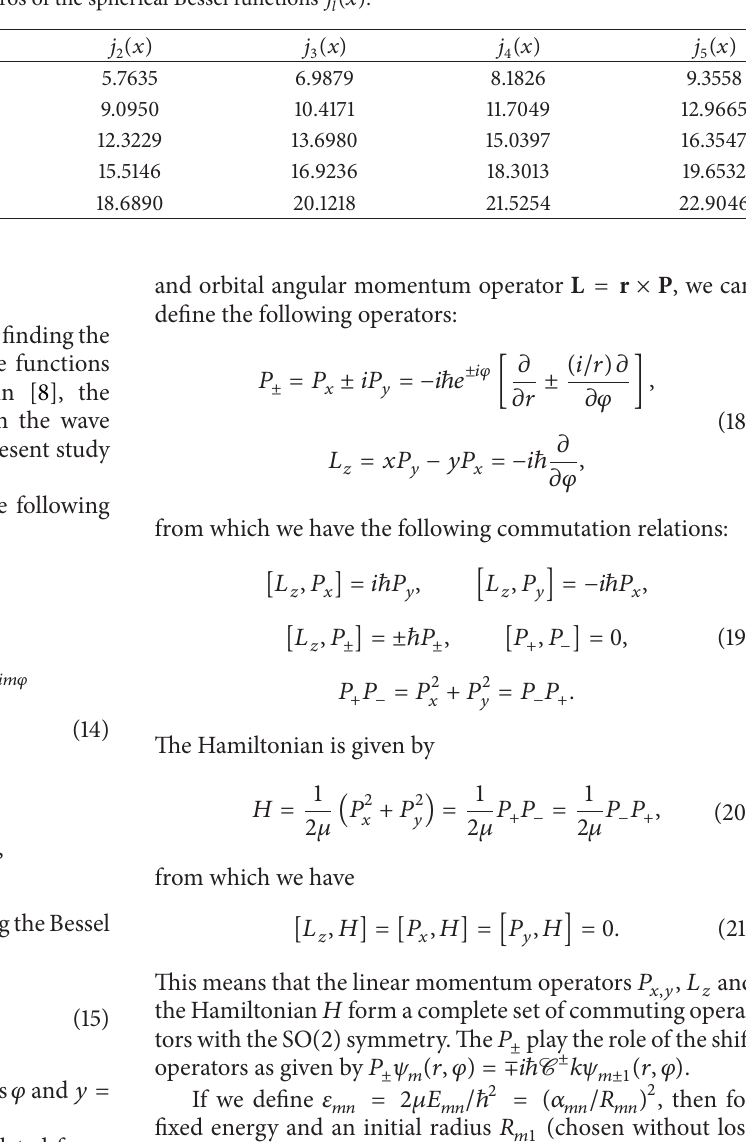
Table 2: Zeros of the spherical Bessel functions 𝑗 𝑙 (𝑥)